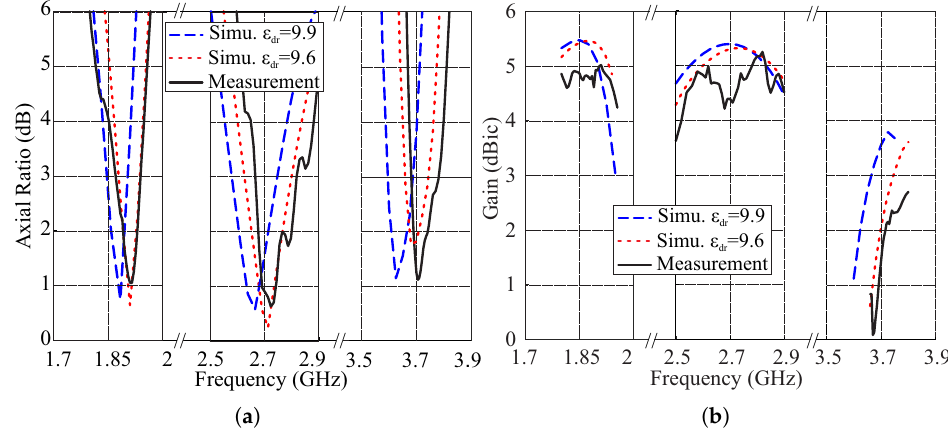
Figure 10. Simulated and measured results of the proposed antenna for θ = 0°: ( a ) Axial ratios; ( b )